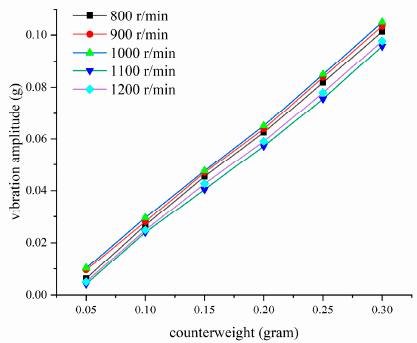
Figure 15. Vertical amplitude diagram of counterweight.